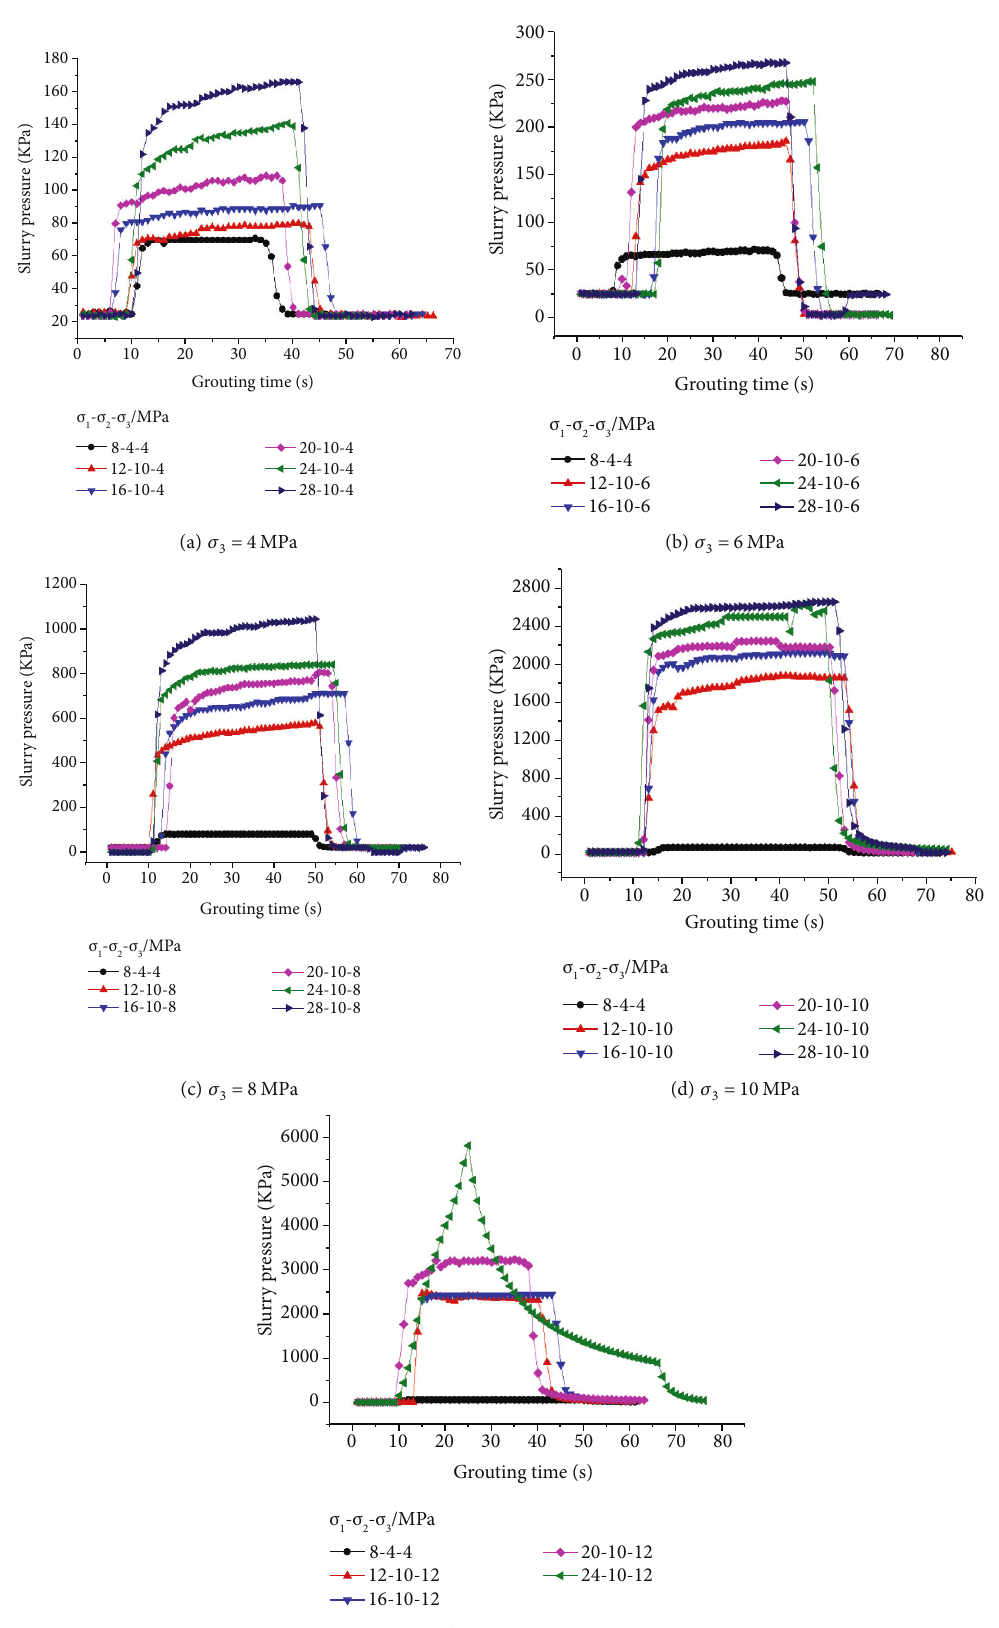
Figure 13: Grouting pressure under di ff erent three-dimensional stress